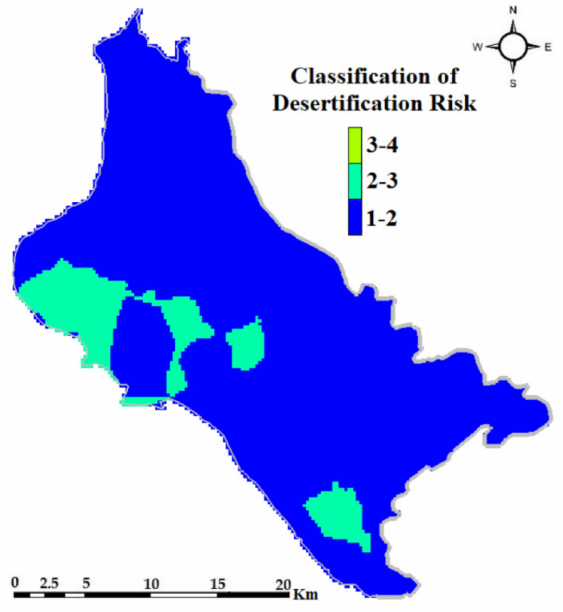
Figure 8. Map of Classification of Desertification Risk for Lake Karla